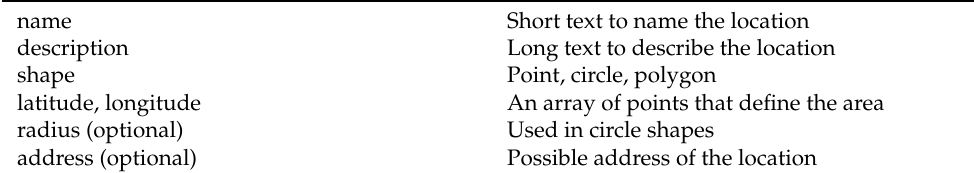
Table 2. Properties of outdoor location class.